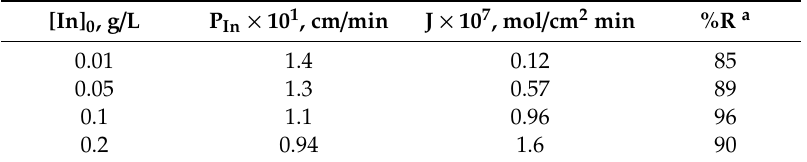
Table 7. Influence of the initial In(III) concentration in the feed phase on metal transport. [In] 0 , g / L P In × 10 1 , cm / min J × 10 7 , mol / cm 2 min %R